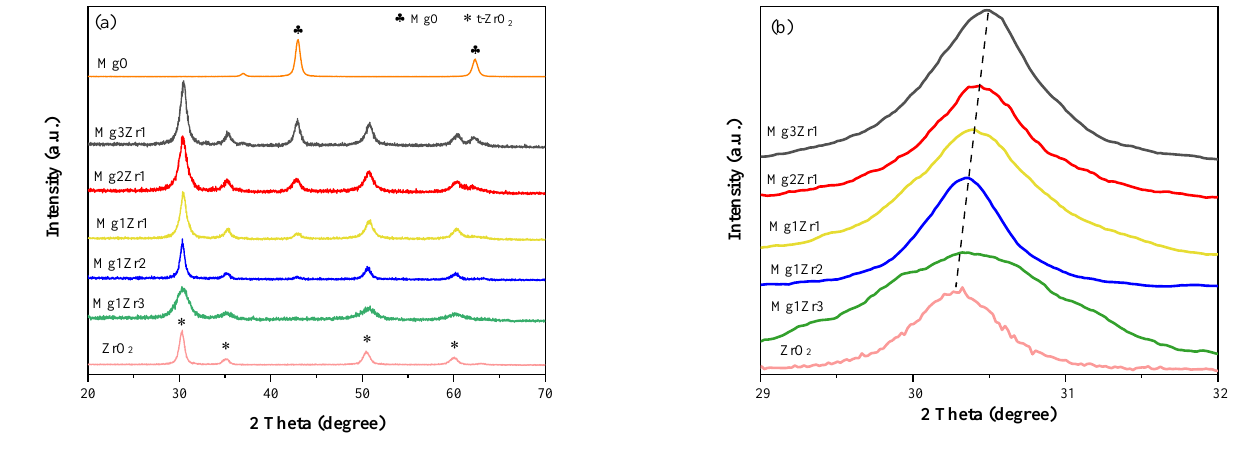
Figure 2. ( a ) XRD patterns of Mg-Zr composite oxides with different Mg/Zr ratios; ( b ) same as ( a ) but in region 2 θ = 29–32. Table 3. Texture properties and surface basicity of various Mg-Zr composite